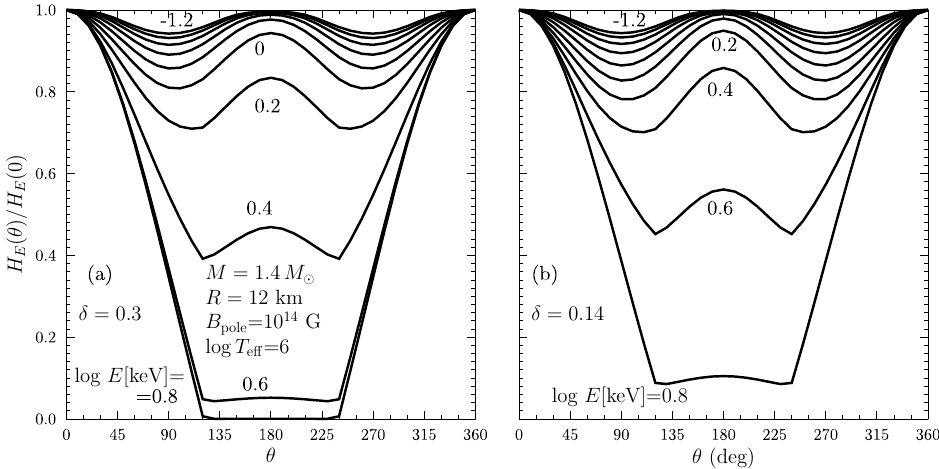
Figure 9. Theoretical lightcurves for a neutron star with M = 1.4 M B pole = 10 14 G with an extra hotspot of angular size ϑ 0 = 10 ◦ on one magnetic pole versus phase angle θ at extra heating parameter δ = 0.3 ( a ) and 0.14 ( b ). The curves are for photon energies log E [keV]= 1, 0.8, . . . ,0.8. See the text for − −